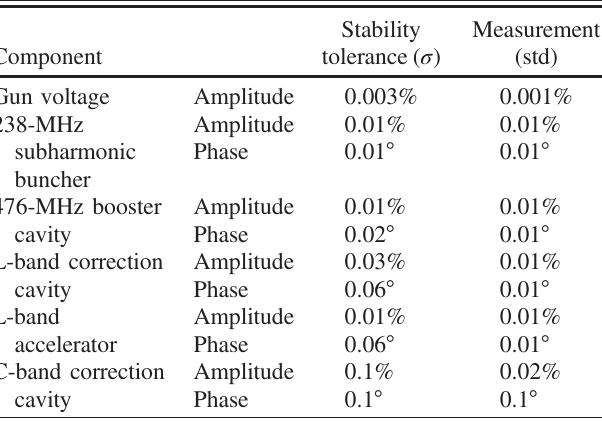
TABLE II. Stability tolerance and realized performance of SACLA-injector rf components.